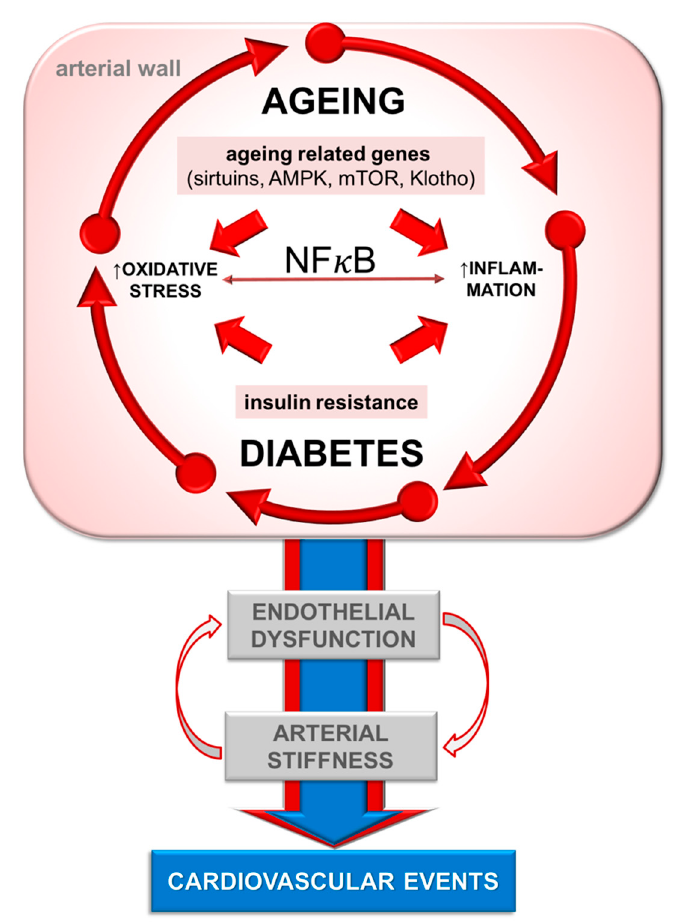
Figure 1. Interplay of mechanisms of arterial ageing in diabetes. NF κ B—nuclear factor κ B; AMPK—AMP-activated protein kinase; mTOR—mechanistic/mammalian target of rapamycin.